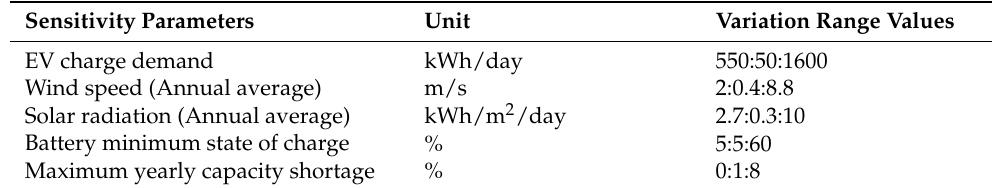
Table 16. Ranges of the sensitivity analysis parameters considered for the optimal charging station. Sensitivity Parameters Unit Variation Range Values EV charge demand